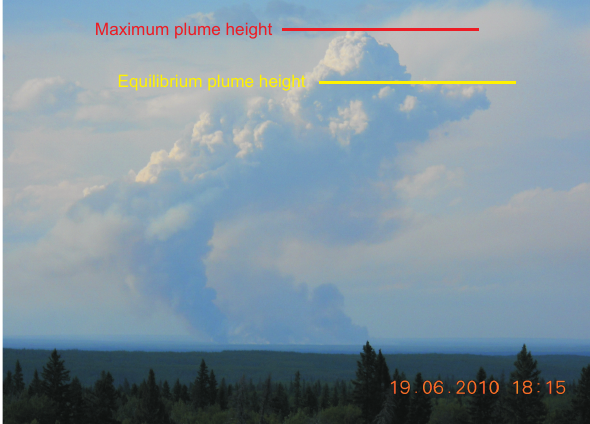
Figure 2. Illustration of the equilibrium and maximum plume heights for observation. Zoomed-in photo taken from the Whitefish lookout tower on 19 June